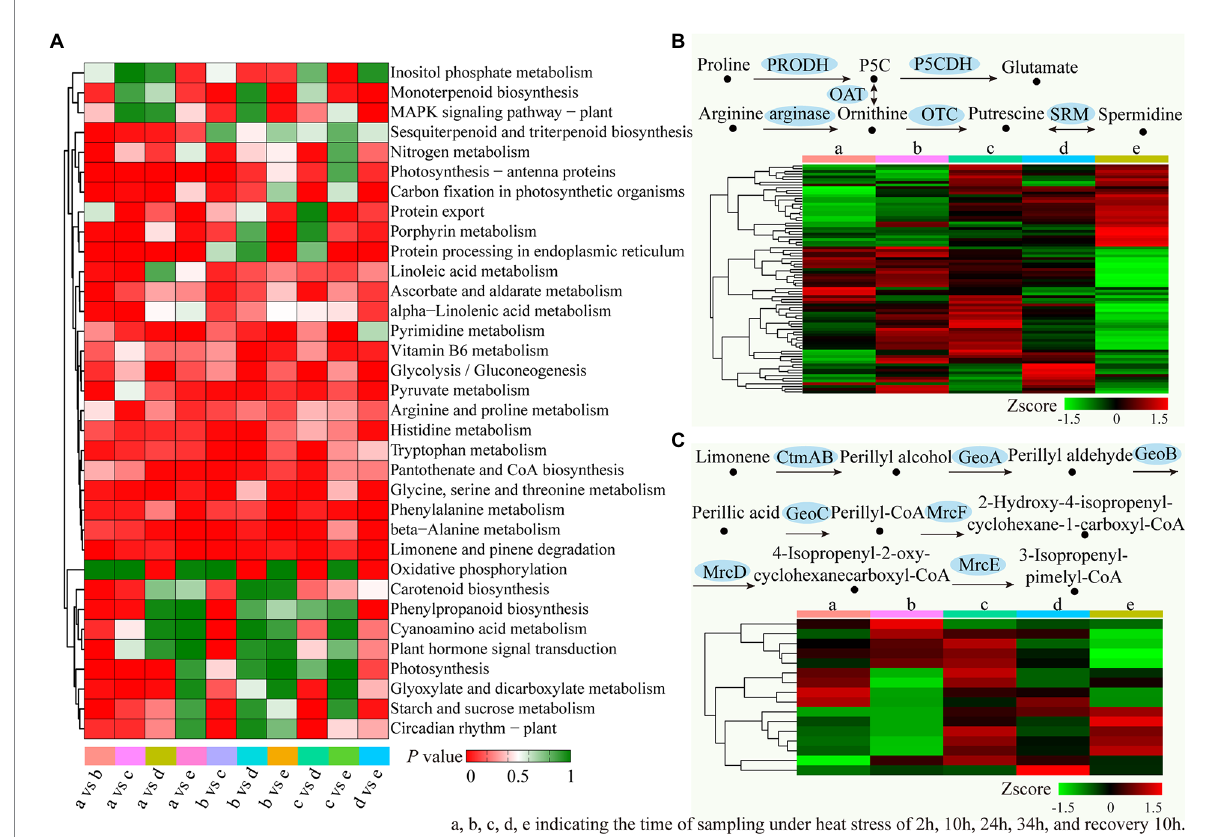
FIGURE 8 Enriched KEGG pathways analysis of the DEGs in different treatments time period. (A) The significant p values of each KEGG term in different treatments were shown by a heatmap. Red indicated significantly enriched KEGG terms. (B) Expression analysis of the unigenes related to the “arginine and proline metabolism” pathway. (C) Expression analysis of the unigenes related to the “Limonene and pinene degradation”